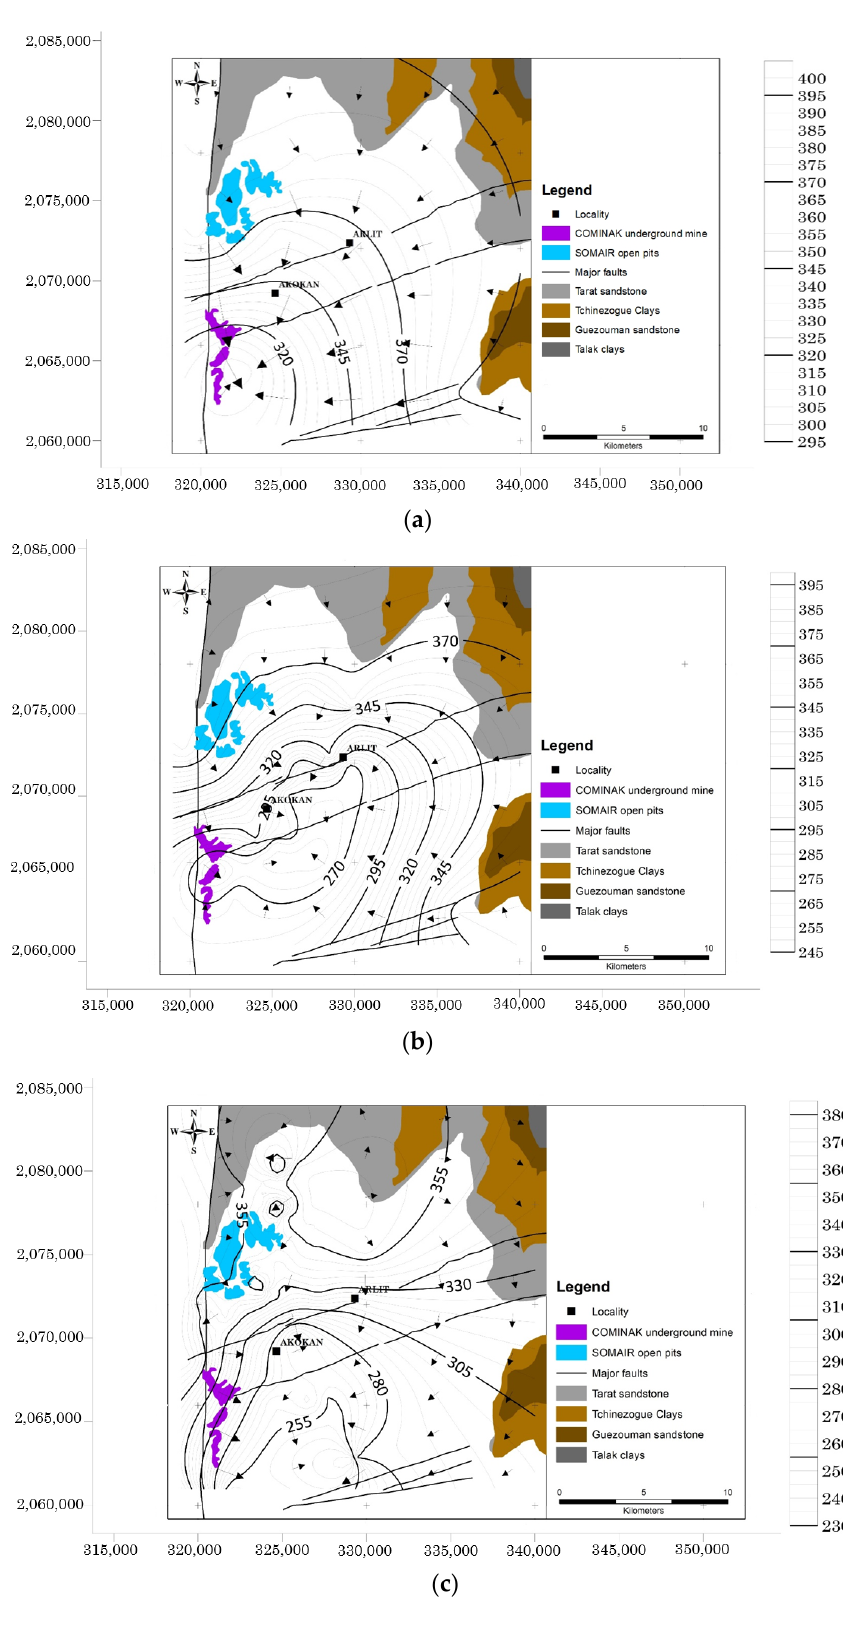
Figure 5. Water level contour maps, measured in ( a ) December 1977, ( b ) December 1999, and ( c ) December 2019, showing the dynamic of depression cones evolution in the study area.